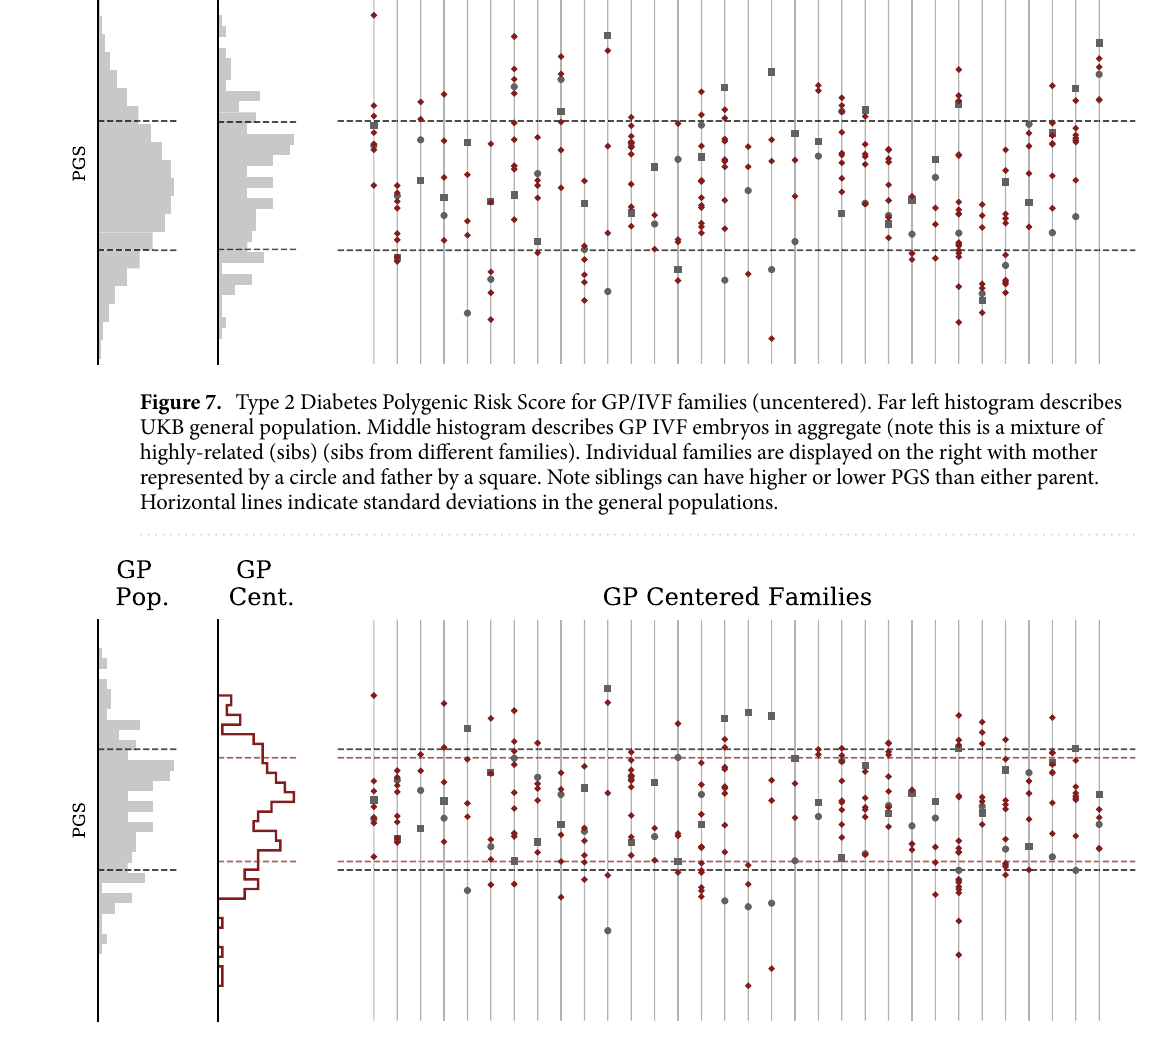
Figure 8. Type 2 Diabetes Polygenic Risk Score for GP/IVF families (centered). Far left histogram describes GP embryos in aggregate. Middle histogram describes GP IVF embryos after recentering with respect to parental midpoint. Individual families are displayed on the right with mother represented by a circle and father by a square. Families on right are displayed after recentering at midparent PGS. Again, the population standard deviations are marked with horizontal